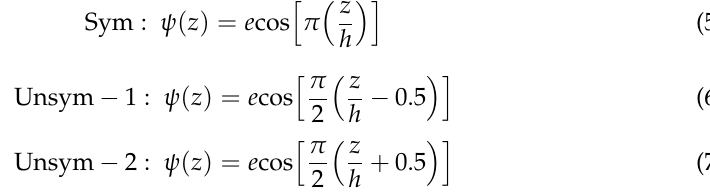
using cosine functions. Here, e ( 0 ≤ e ≤ 1 ) is the porosity parameter, and all the five porosity distributions have the same porous volume for a given value of e . According to the linear rule of mixtures, the equivalent material properties ℘ ef f ( z ) at any point within the FG porous plate is calculated by in terms of two base material properties ℘ c and ℘ m of ceramic and metal, the volume fraction V c ( z ) and the porosity ψ ( z ) . The mid-surface surface (cid:118) ∈ (cid:60) 2 with its boundary ∂(cid:118) can define a dimension-reduced 2D hierarchical model in which the displacement field u ( x , y , z ) is decomposed into Θ ( x , y ) · Q ( z ) . Here, Θ ( x , y ) and Q ( z ) indicate the in-plane triple vector function and the assumed thickness monomial, respectively. The classical plate and shell theories and the hierarchical models [29–31] were developed according to this dimension reduction technique. Referring to reference [31], the (3,3,2) hierarchical model, which can be considered third-order SDPT, is expressed by